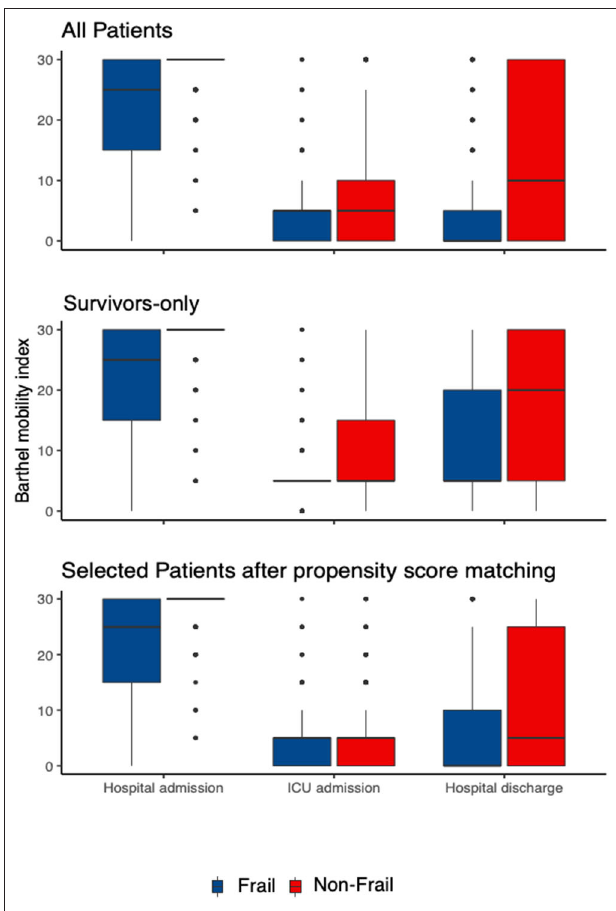
FIGURE 2 | The intrahospital trajectory of the functional status in the patients with frailty vs. non-frailty at three timepoints (“Hospital Admission,” “ICU Discharge,” and “Hospital Discharge”). The functional status is measured as Barthel-Mobility-Index consisting of the two subdomains “Mobility” and “Transfer” of the Barthel-Index, ranging from 0 to 30 (“Mobility-Transfer-Barthel”, MTB). Three patient groups are presented: all patients ( n = 1,172), survivors only ( n = 361) and after selection the propensity-matched cohort ( n = 687). The red boxplots mark the patients with non-frailty and blue the patients with